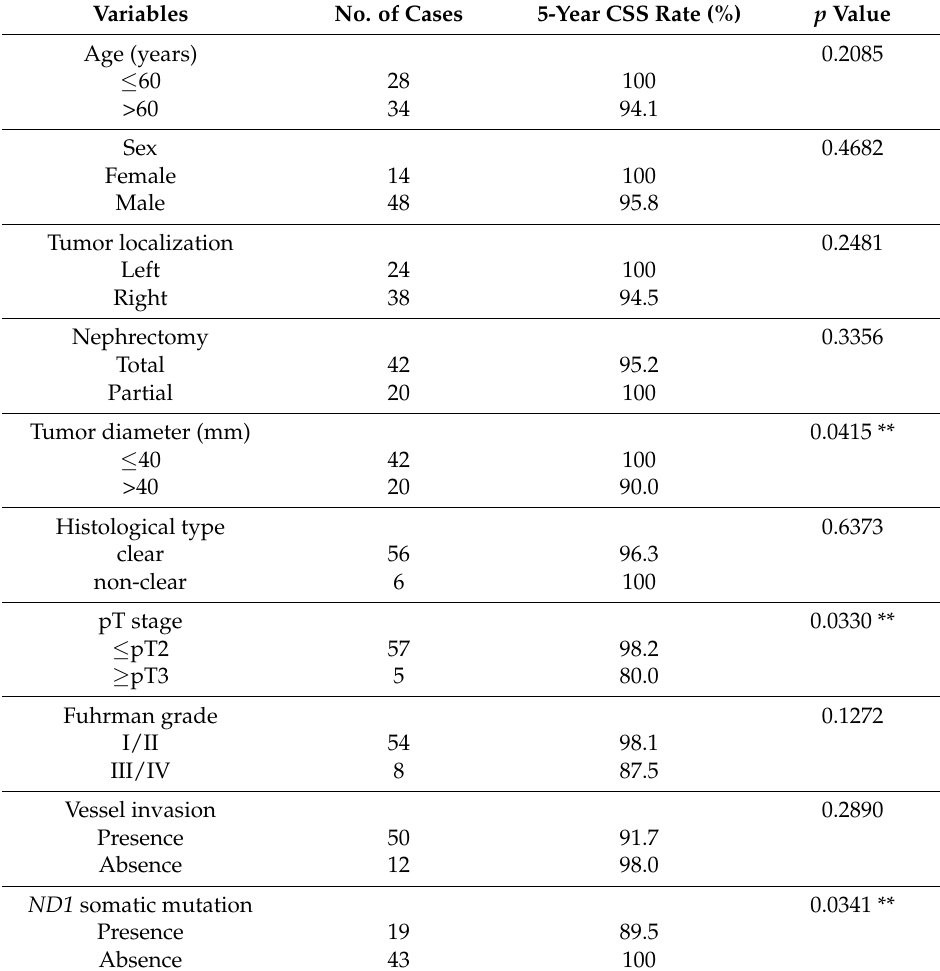
Table 5. Univariate analysis of factors predicting CSS after surgery.